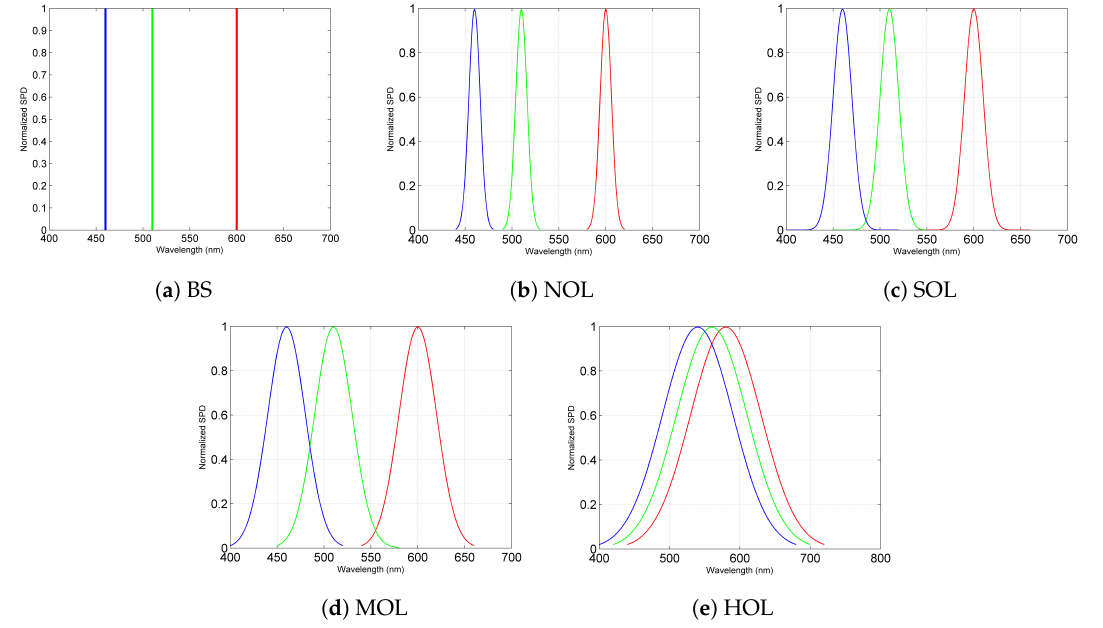
Figure 5. Gaussian spectral sensitivity functions based on the functions of the Canon 5D camera from Figure